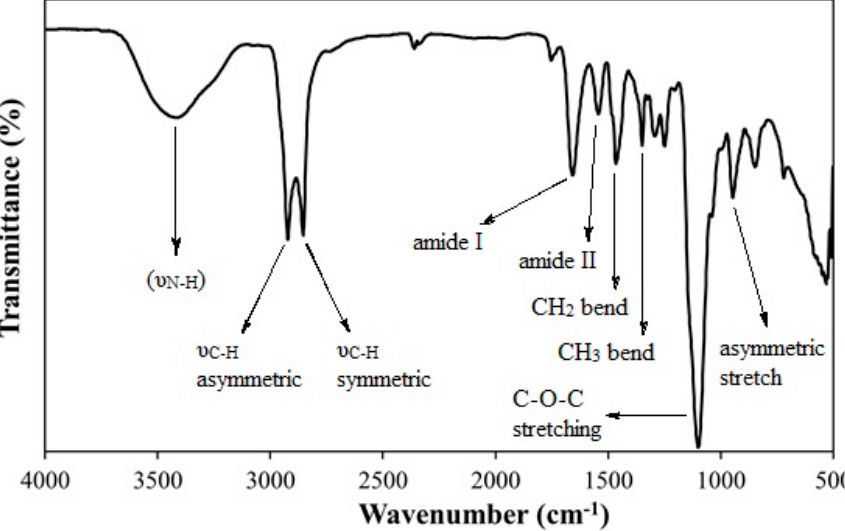
Figure 4. FT-IR spectra of quaternary ammonium gemini surfactants (GS12). Table 3. FT-IR spectral data of the quaternary ammonium gemini surfactants (GS12).